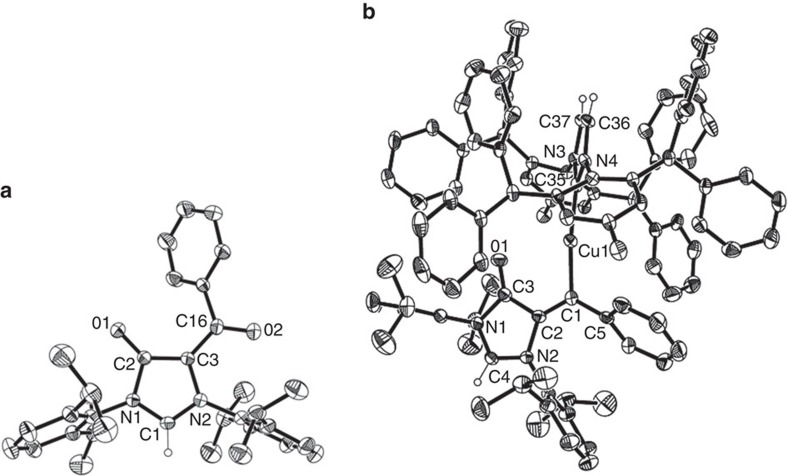
Molecular structure of 6 and 7.(a) Molecular structure of 6 with 20% probability. H atoms in aryl rings have been omitted for clarity. (b) Molecular structure of 7·CH2Cl2 with 20% probability. The counterion (NTf2−) and CH2Cl2 in 7 and H atoms in aryl rings have been omitted for clarity.